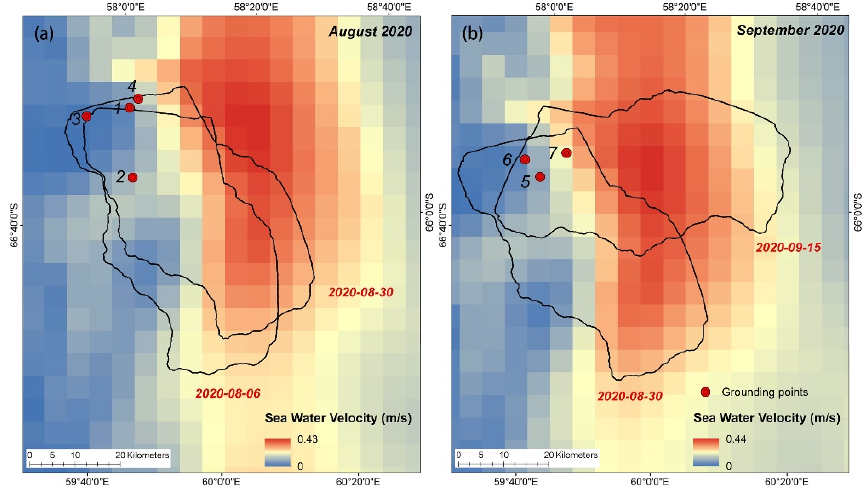
Figure 7. Mean sea water speed around iceberg D28 and the grounding points in ( a ) August 2020 and ( b ) September 2020.